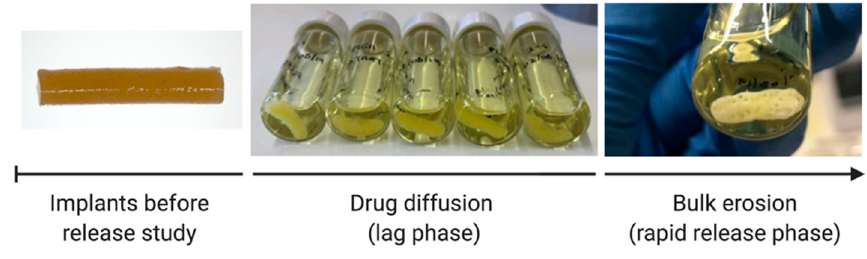
Figure 4. Structural changes to the 8:2-PLGA-3% implants throughout the release study, characterised by initial polymer swelling, followed by macroscopic pore formation at the onset of the bulk erosion period. Diffusion of tartrazine dye (0.2% w / w ) from the implants caused the release media to appear yellow in colour.